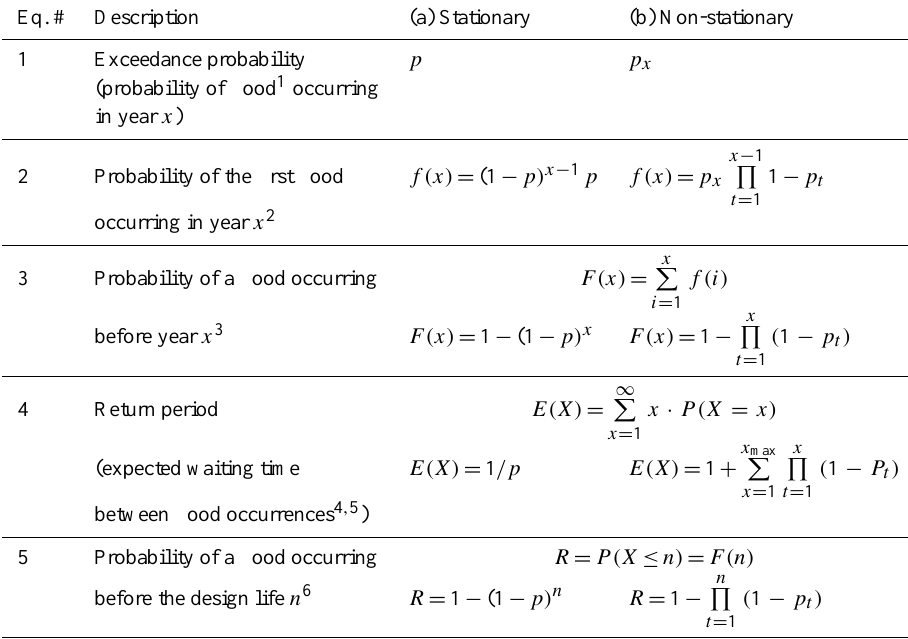
Table 1. Flood calculations using stationary and non-stationary distributions (adapted from Salas and Obeysekera, 2014). Eq.